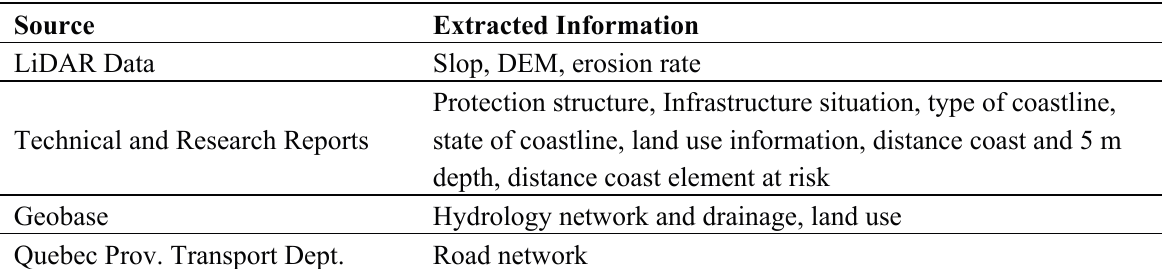
Table 4. The list of data sets used for erosion risk assessment.